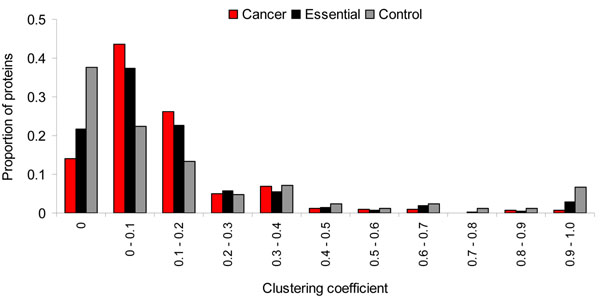
Distribution of clustering coefficients of the cancer, essential, and control proteins.